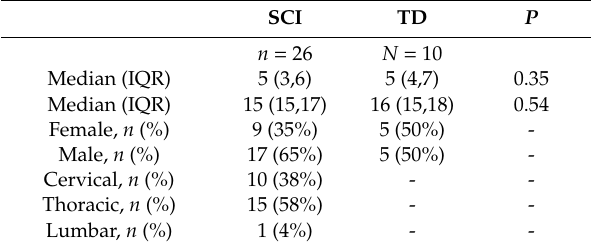
Table 2. Summary of categorical variables of typically developing children and children with spinal cord